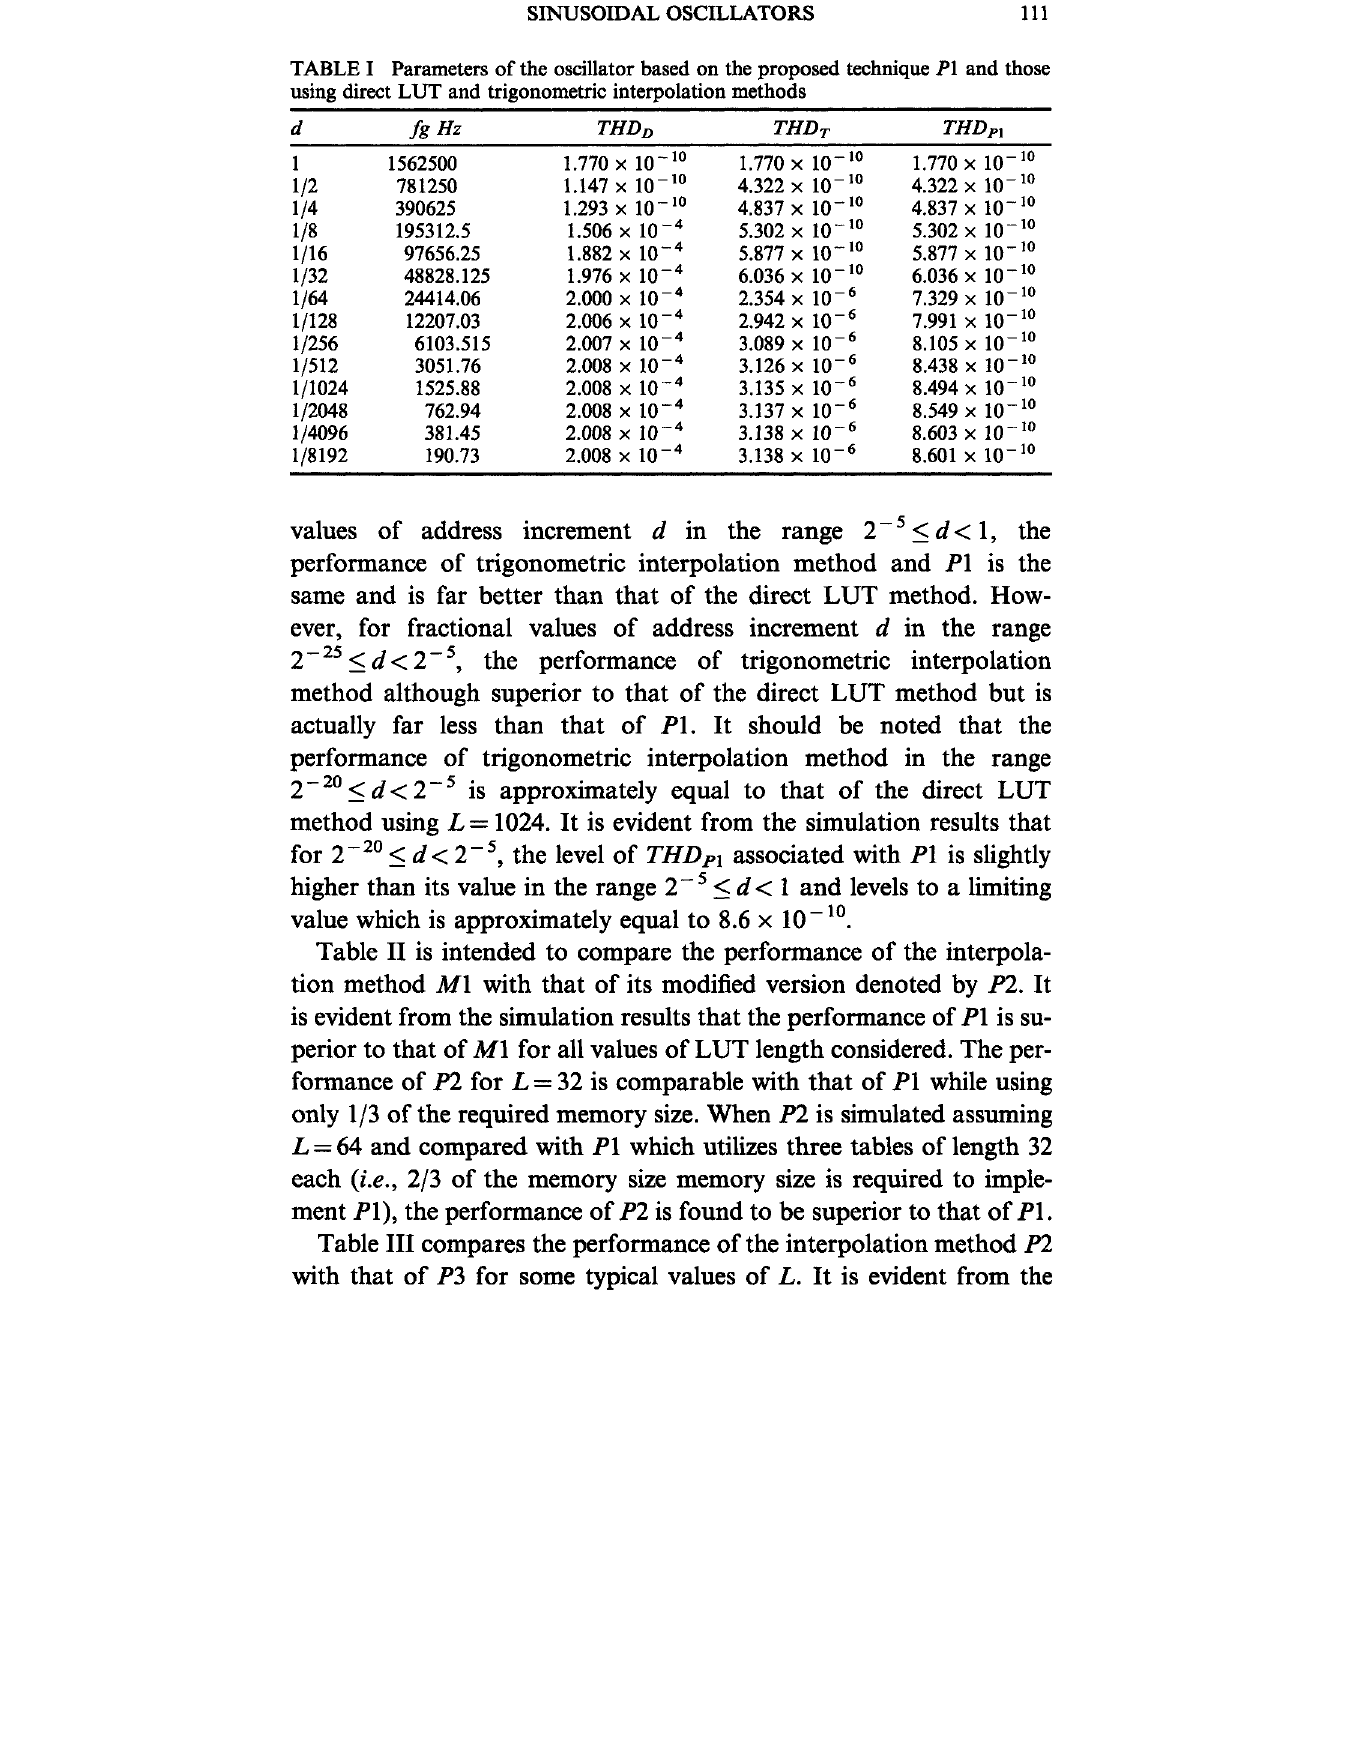
Parameters of the oscillator based on the proposed technique P1 and those using direct LUT and trigonometric interpolation methods d fg Hz